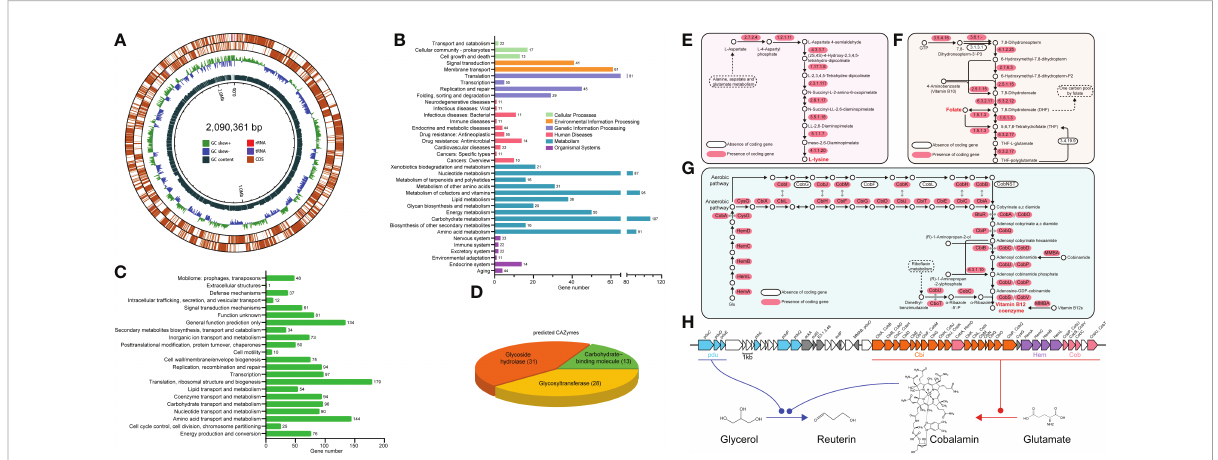
FIGURE 4 General genome features of L. reuteri RGW1. (A) Circular draft genome maps of the L. reuteri RGW1 chromosome. From outside to the inside: forward CDSs, reverse CDSs, GC skew, GC content. (B) Histogram representing the number of genes included in each KEGG pathway. (C) COG classes of predicted protein sequences of L. reuteri RGW1. (D) Predicted CAZymes of L. reuteri RGW1. (E) L-lysine biosynthesis pathway. (F) Folate biosynthesis pathway. (G) Cobalamin biosynthesis pathway, the sequence homology and functional equivalency between aerobic and anaerobic pathway enzymes are indicated by gray arrows. (E-G) were adapted from KEGG pathway. (H) pdu-cbi-hem-cob gene cluster and the proposed reuterin biosynthesis pathway in L. reuteri RGW1.